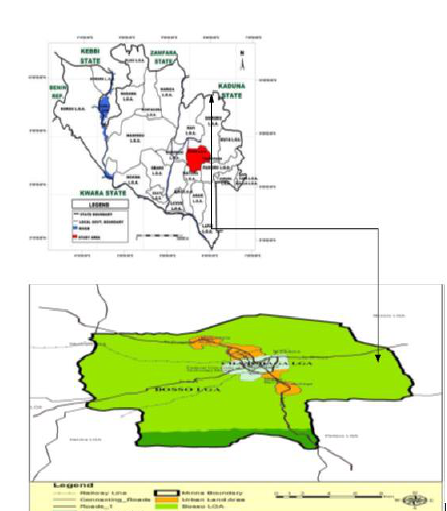
Figure 1. Location of Niger State and Minna Source: Ministry of Land and Housing,